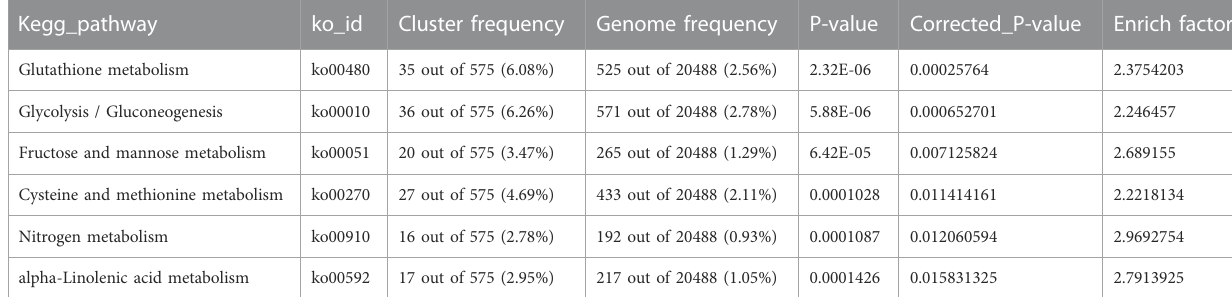
TABLE 3 Enriched KEGG pathways for DEGs in 24 h root